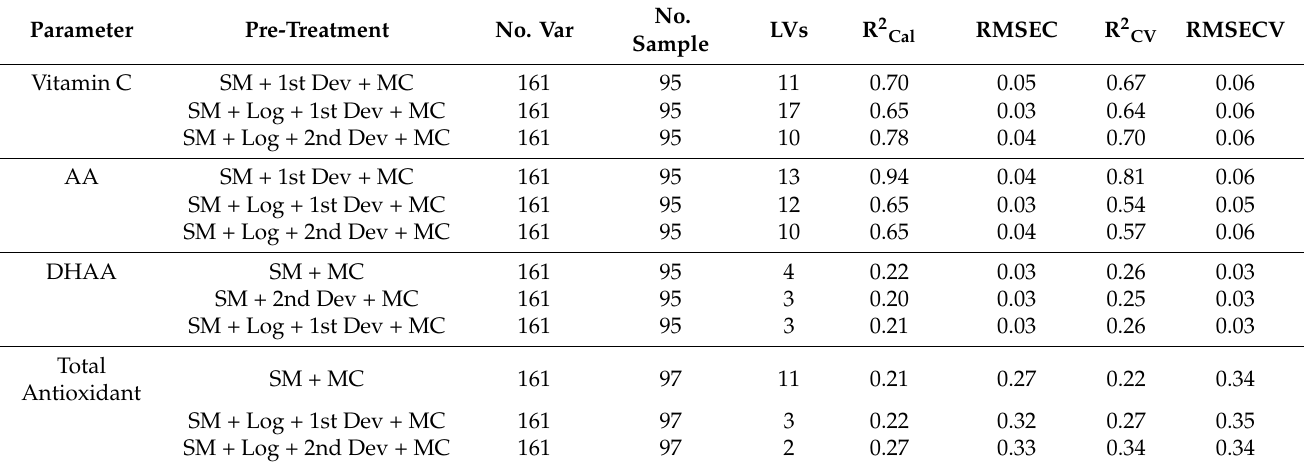
Table 3. Calibration statistics for the PLSR models of the internal constituents of fresh goji berries (SM = Smoothing, Dev = derivative, MC = mean centering) in the NIR region (900–1700